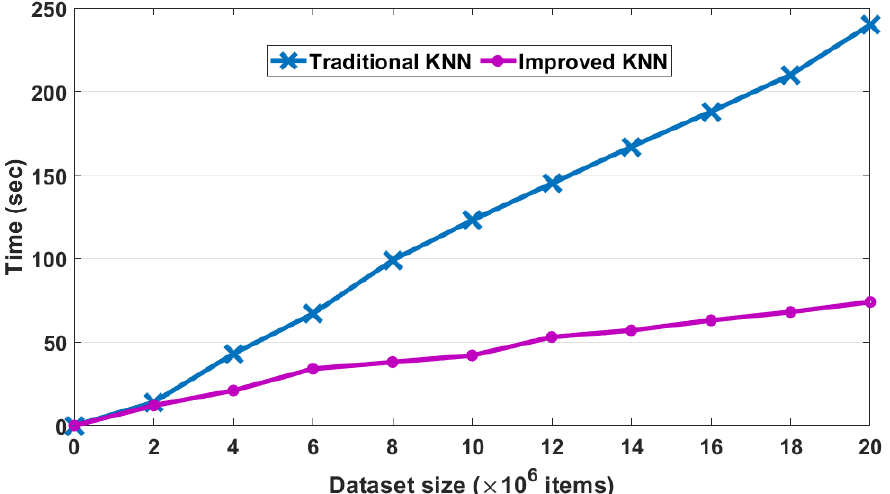
Figure 11. Time performance for disease